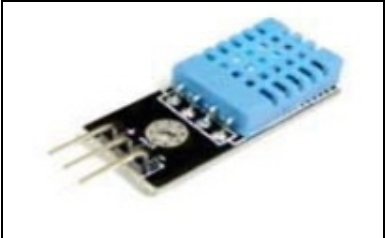
Figure 9. Temperature and humidity sensor (DHT-11) [26].